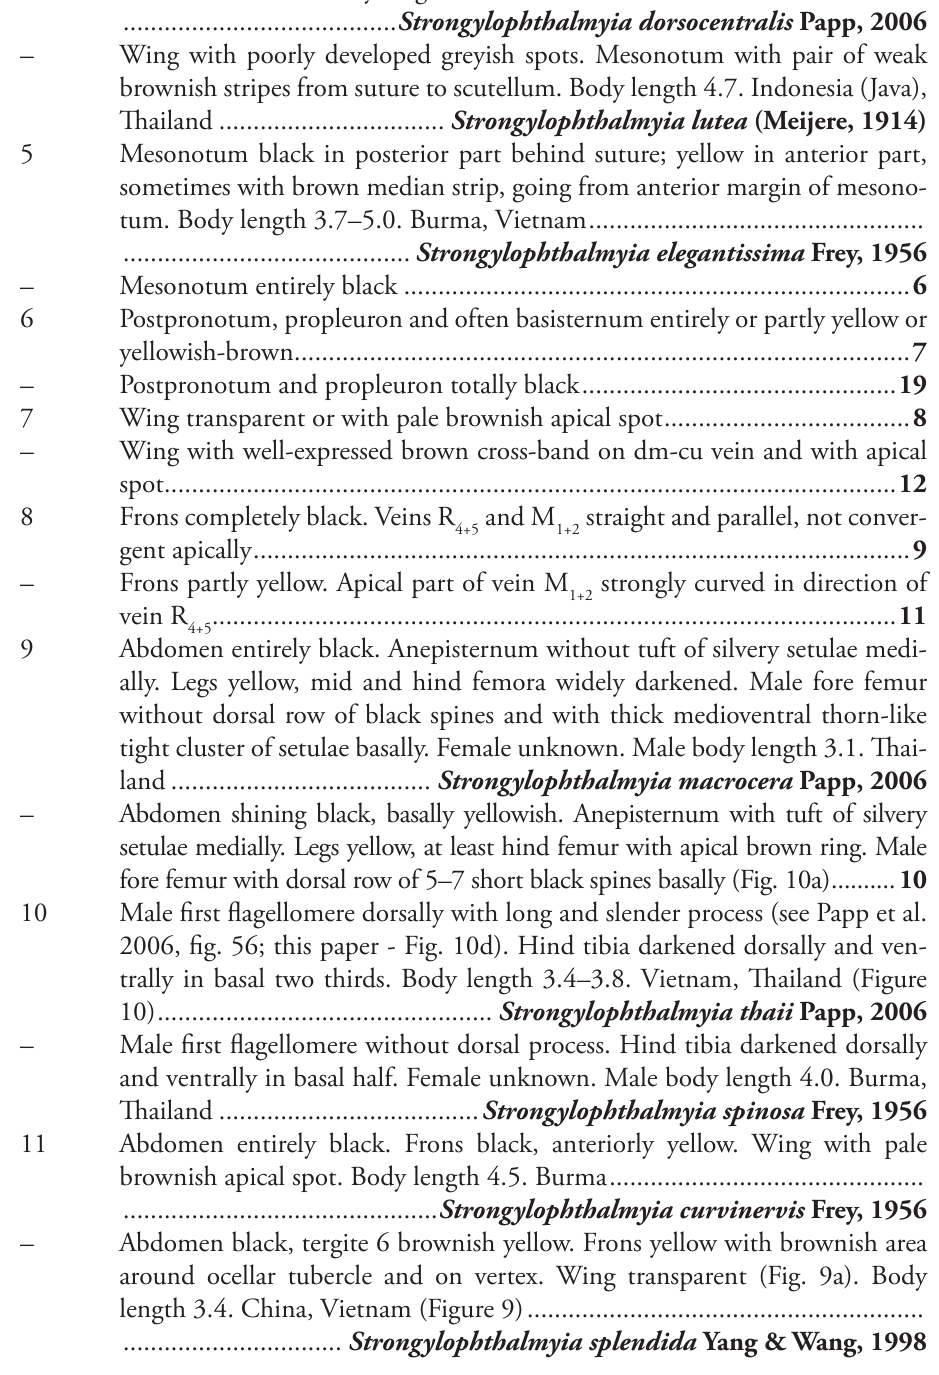
– Postpronotum, propleuron and often basisternum entirely or partly yellow or